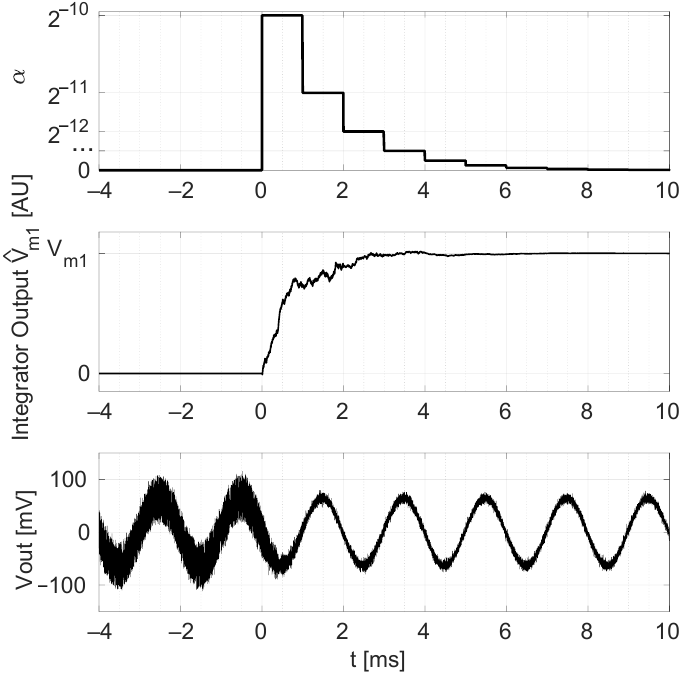
Figure 15. Time domain plots for the system with active SS-ORLs and stepwise changes in adapta- tion parameter: imposed time-evolution of the adaptation parameter α used in the SS-ORLs ( top ), the integrator output ˆ V m 1 ( middle ), and V out of Figure 7 ( bottom ). A magnetic field with amplitude 780 µ T and frequency 500Hz is